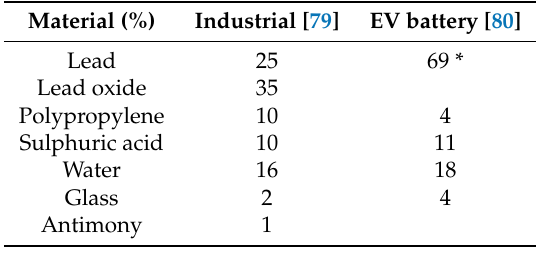
Table 4. Composition (by percentage weight) of two leading Pb-A